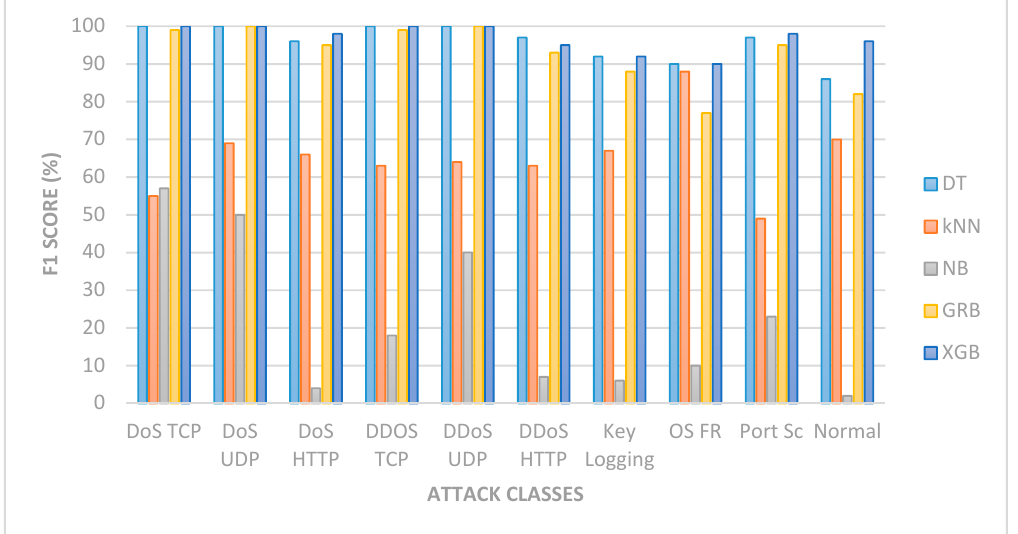
Figure 13. F1 score of multiclass classification Instances.